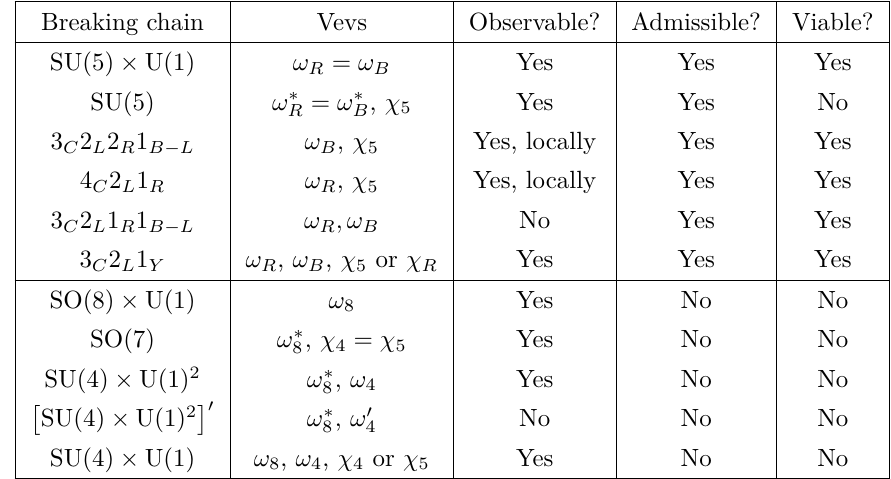
Table 1 . Summary of the considered breaking patterns. In each case, we indicate which vevs should be non-zero in order to trigger spontaneous breakdown towards the relevant subgroups. A starred vev (e.g. ω ∗ ) can however vanish without altering the nature of the vacuum. As explained 8 in the main text, non-observable phases correspond to minima which cannot be global, while non-admissible breakings occur towards subgroups of SO(10) which do not contain the Standard Model. An admissible breaking is called viable if it can obey the proton stability and gauge coupling unification constraints (more detail is given in section